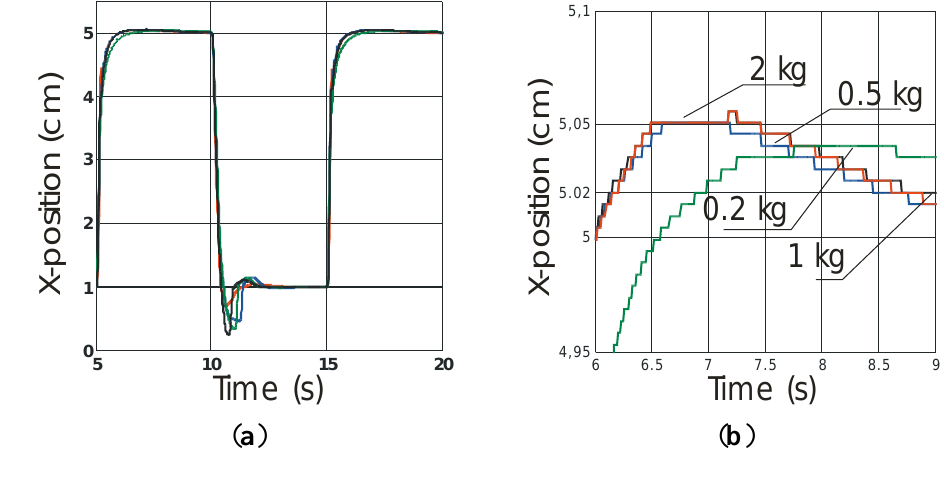
Figure 7. Step responses performed by our plastic wire McKibben muscle driving various loads ( a ) and ( b ) Close-up of final convergence towards the desired